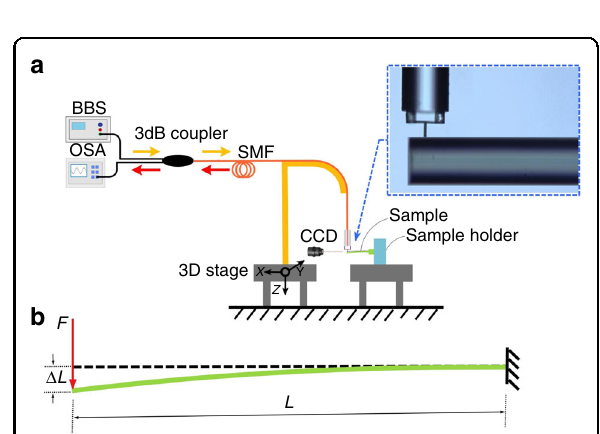
Fig. 4 Experimental setup. a Measurement system setup. The inset shows a CCD image of pushing against the SMF of the clamped- beam probe sensor. b Schematic diagram of cantilever-beam de fl ection under point